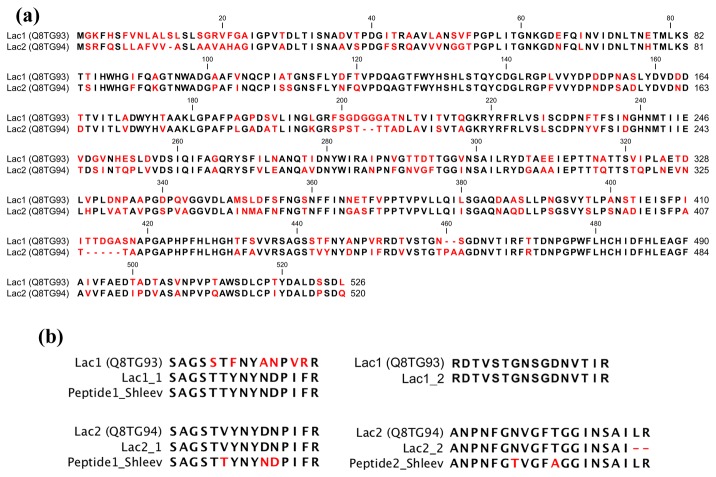
Aligment of reported lacasses sequences and Lac1 and Lac2 peptides.(a) Alignment of Lap1 (UniProtKB/Swiss-Prot Q8TG93) and Lap2 (UniProtKB/Swiss-Prot Q8TG94) from

T

. pubescens
 CBS 696.94. (b) Alignment of Lac1 and Lac2 peptides with Lap1 and Lap2, respectively, and tryptic peptides described by Shleev et al 2007. Alignments were carried out using Clustal Omega and figures were using CLC Sequence Viewer. Different residues are colored in red.